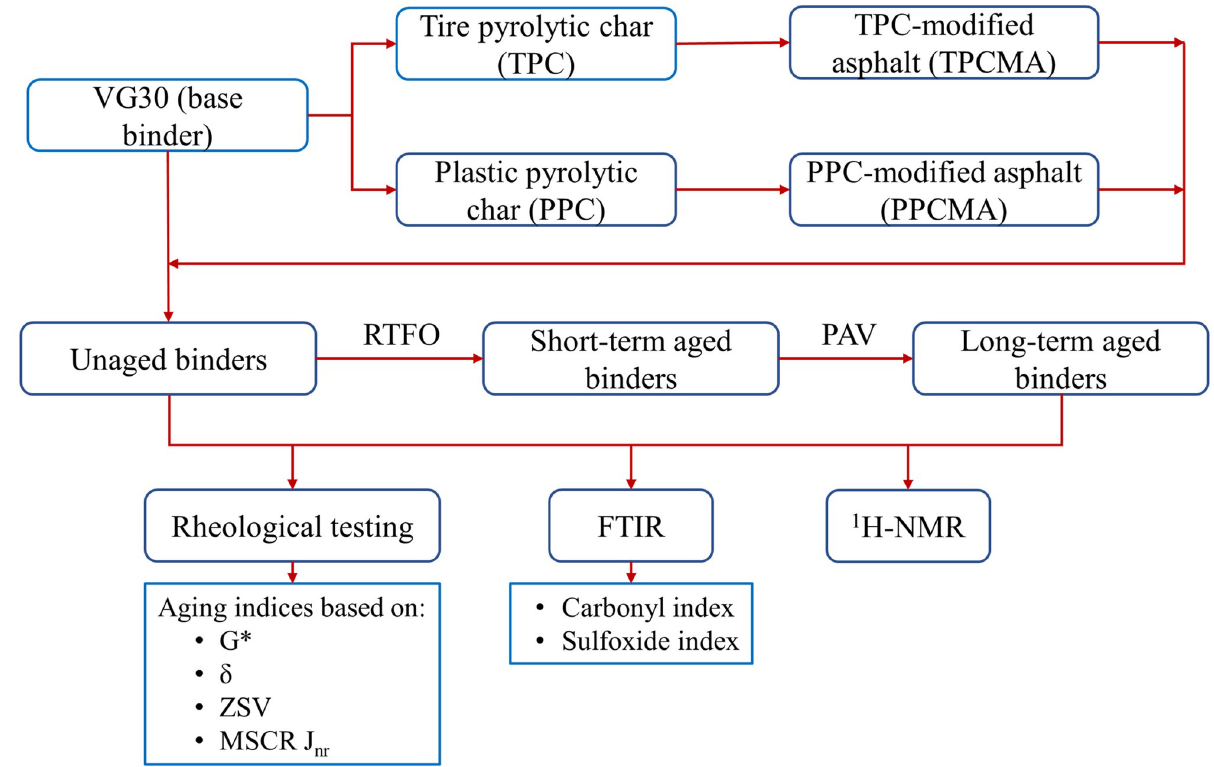
Fig 1. Experimental